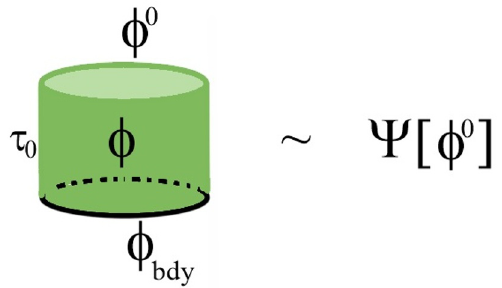
Figure 3 . Euclidean path integral construction for the state of a CFT on S d used in the BHMC construction. This is obtained from the standard path integral defining the vacuum state by truncating at some past Euclidean time − τ 0 and choosing some boundary conditions there, with additional boundary degrees of